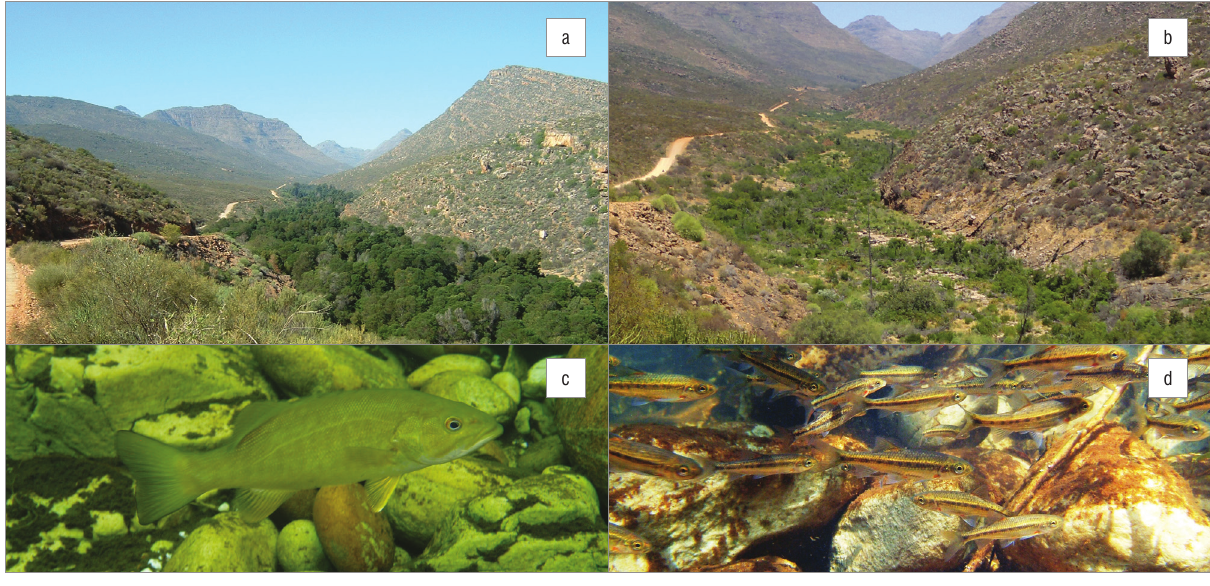
Figure 1: Map showing location of the Rondegat River. The area targeted for fish rehabilitation was between the Rooidraai waterfall and the water abstraction weir; alien plants were cleared from this area and a further 10 km upstream.